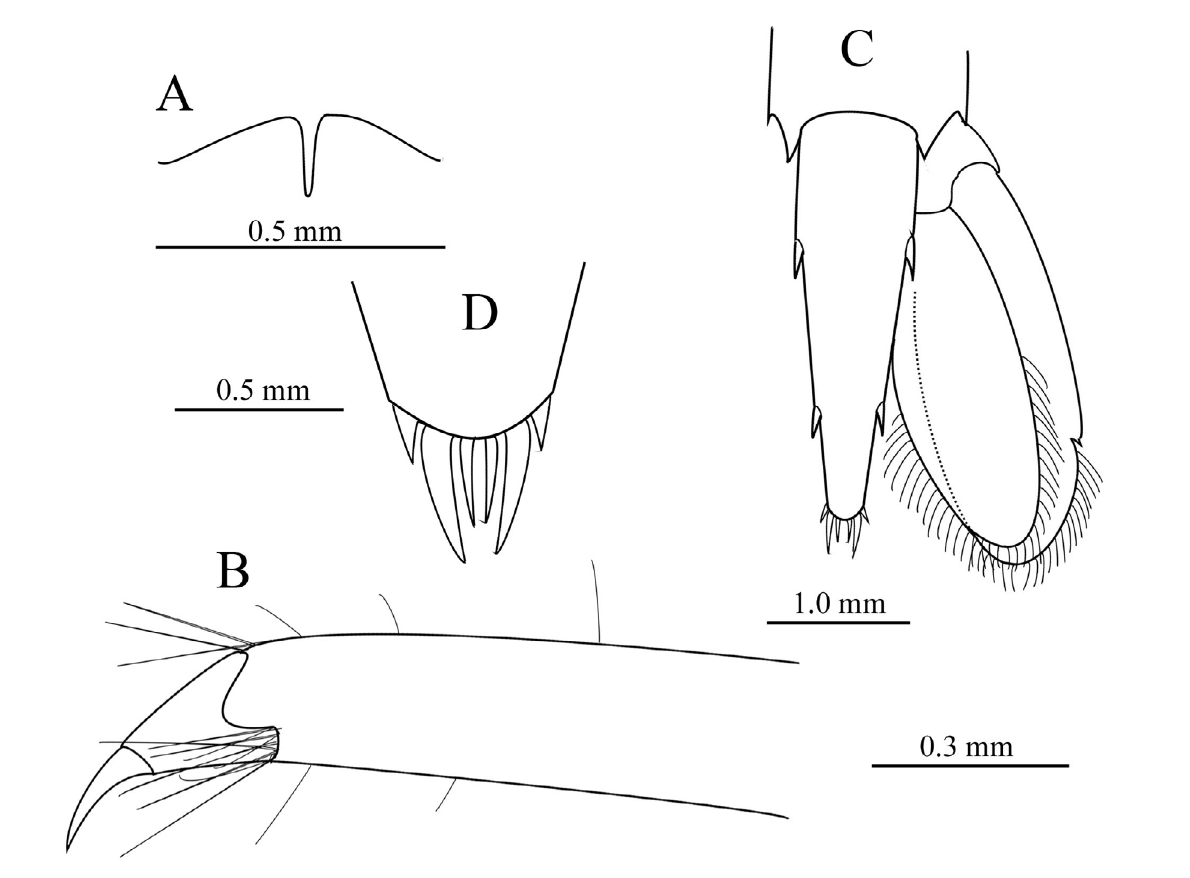
Figure 5. Actinimenes koyas sp. nov. holotype, ovigerous female, CL 3.5 mm, NBFGR/PALAKOY – 01. A , Fourth sternal plate with median incision (inner view); B, left dactylus of the third pereopod (closer view); C , dorsal view of telson with uropod; D , posterior end of telson (closer